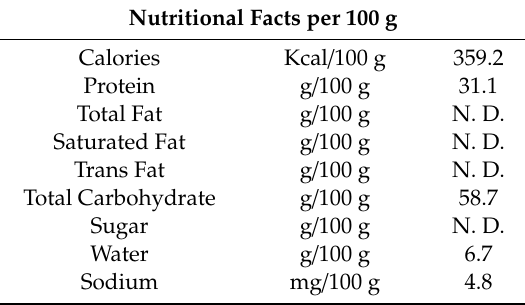
Table A1. Nutritional facts of